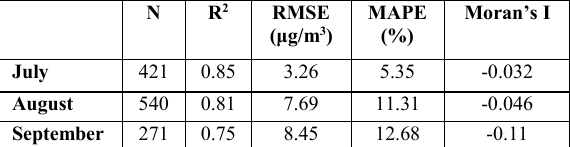
Table 3. Statistical results of monthly GWR